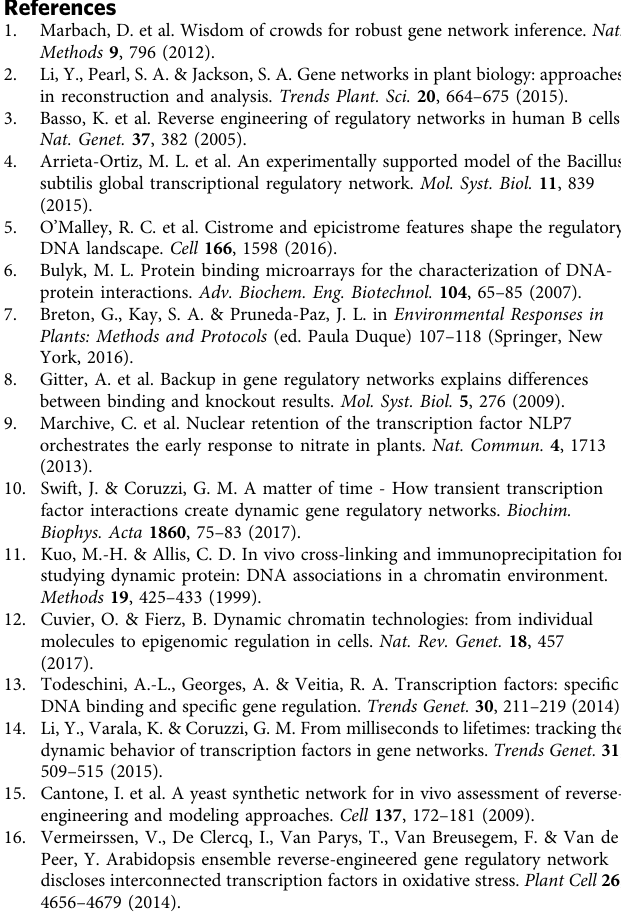
The previously published dynamic factor graphs (DFG) network inference machine- learning code is available at [https://github.com/piotrmirowski/DFG4GRN] 49 .